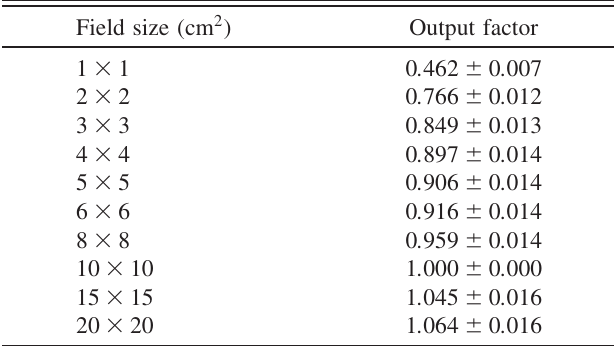
TABLE IV. Output factor in the cylindrical phantom given by square fields. These data are represented in Fig. 11.